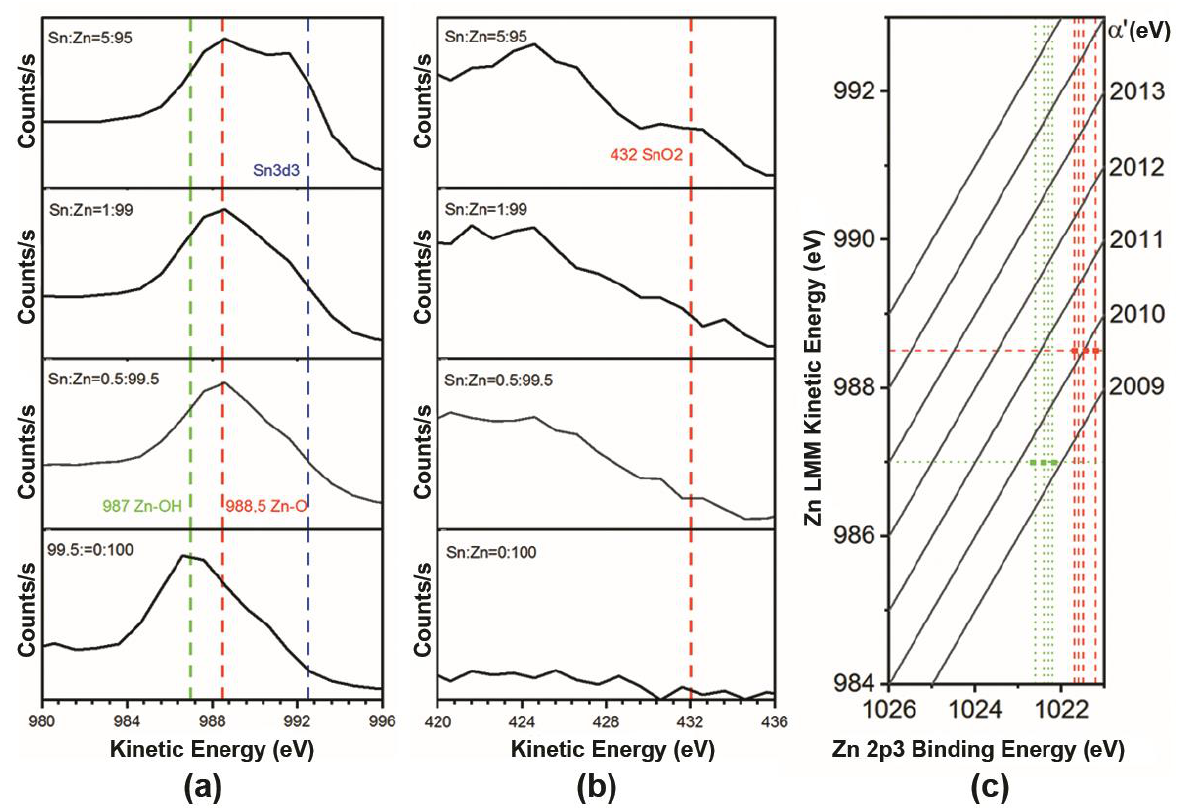
Figure 9. Spectra of Auger electron series of Zn LMM ( a ), Sn MNN ( b ) of thin ZnO-SnO 2 films materials ZnO, Sn:Zn = 0.5:99.5, Sn:Zn = 1:99, Sn:Zn = 5:95 and Wagner plot ( c ). Green dotted lines correspond to hydroxide groups, and red to oxide ones; the bold dots correspond to modified Auger parameters, respectively.